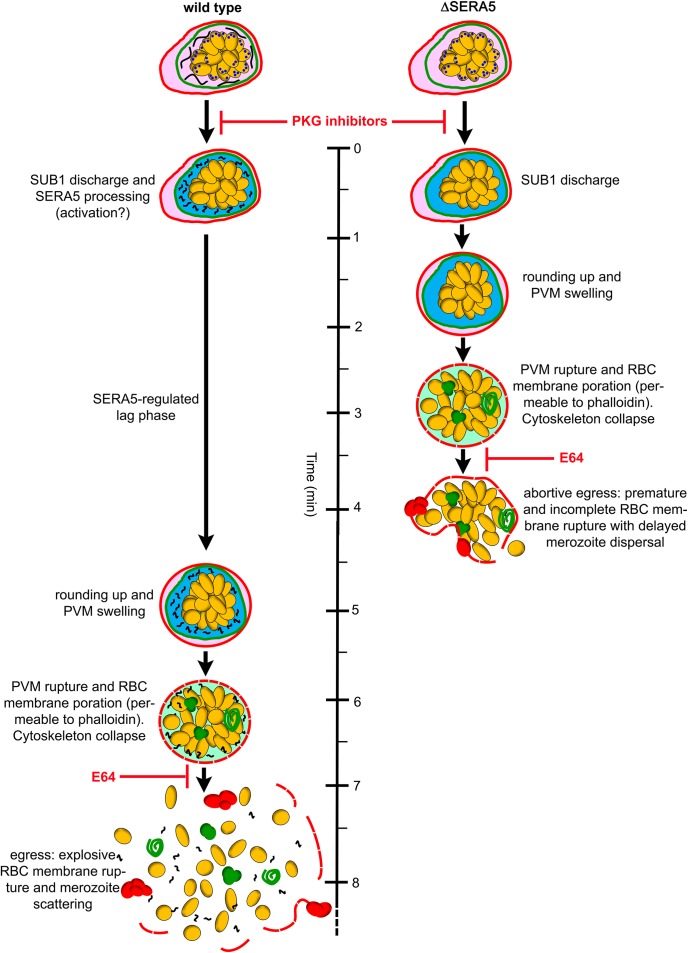
Model for role of SERA5 in regulating a lag phase that enables efficient bounding membrane disruption at egress.Schematic model of the role of SERA5 based on the results of this and previous studies. The erythrocyte and PV membranes of mature schizonts are indicated in red and green respectively. SUB1 in exonemes of mature segmented schizonts is depicted as blue dots, whilst full-length SERA5 is shown as black strands within the PV. Evidence that the PVM becomes porous prior to PKG activation, that PVM disruption results in vesiculated ‘rolls’ of membrane and that erythrocyte membrane rounding up and/or poration is associated with rapid collapse of the host cell cytoskeleton is from earlier work [26, 32]. Timelines shown to egress are approximate minima and are based on reversible inhibition of egress by compound 2. The final step of host cell membrane rupture is sensitive to E64 in both wild type and ΔSERA5 parasites. However, in the presence of E64 the time to PVM rupture is similar for wild type and ΔSERA5 mutants (not indicated schematically). RBC, red blood cell.